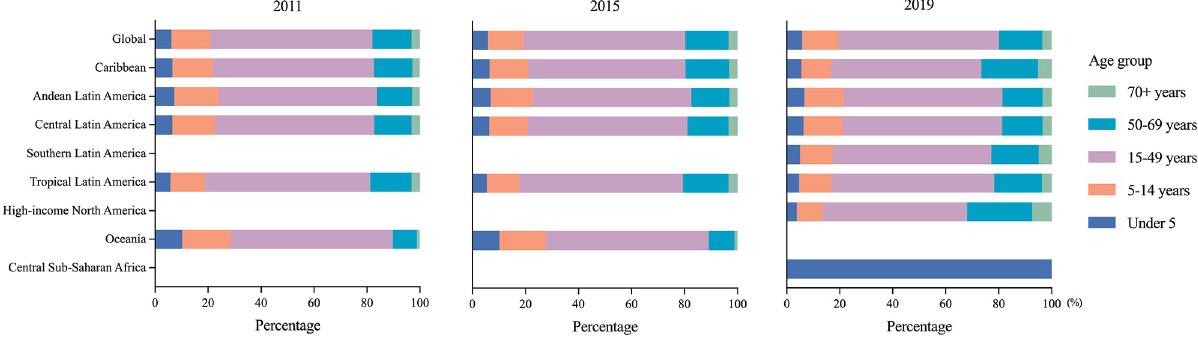
Fig 3. Age group distribution of ZIKV infection episodes by GBD region in 2011, 2015 and